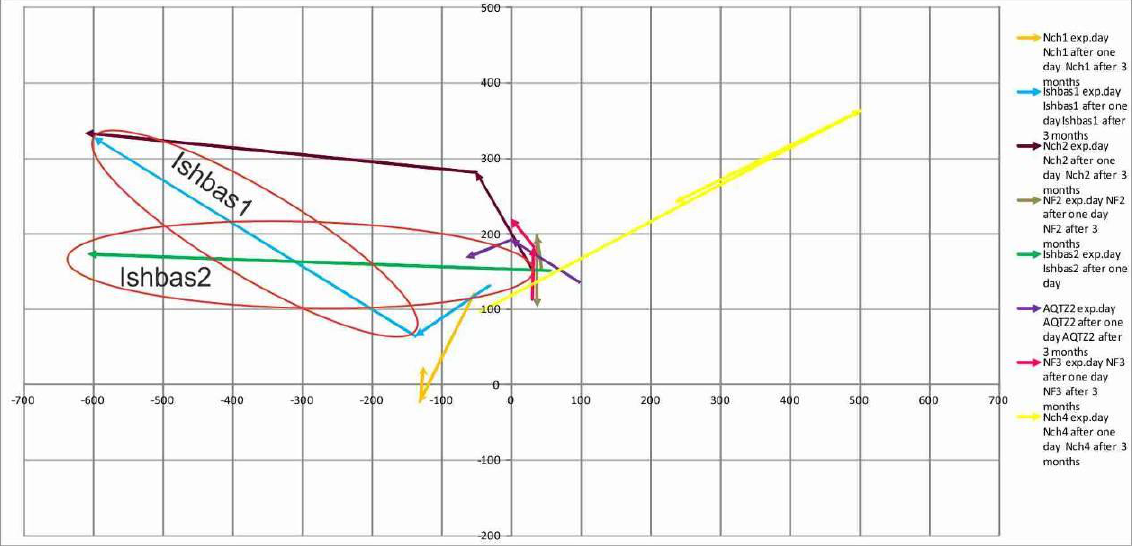
Figure 4. Dispersion of all experimental pieces during the bear trampling experiment in one day and after 3 months. Red ovals indicate Ishbas1 and Ishbas2 flakes. Displacement of these flakes from their original place in one day and after 3 months is clearly evident.